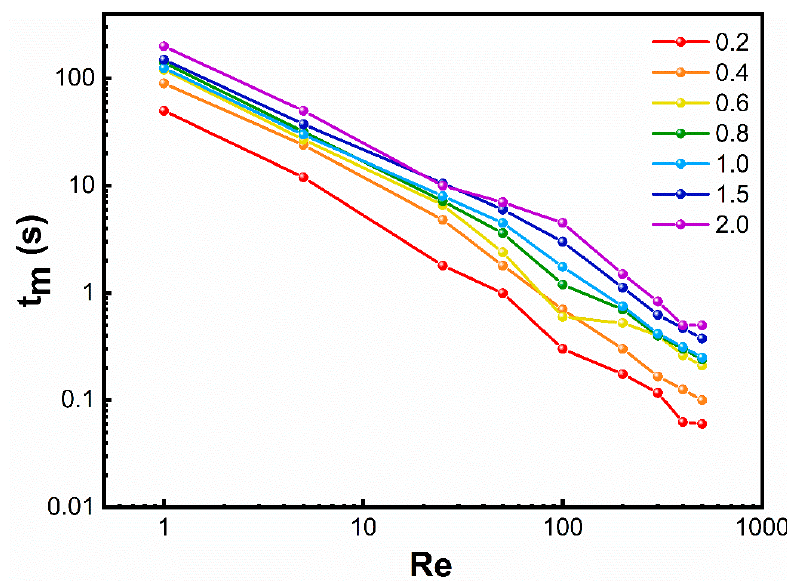
Figure 14. Effect of aspect ratio on mixing time at different Re.